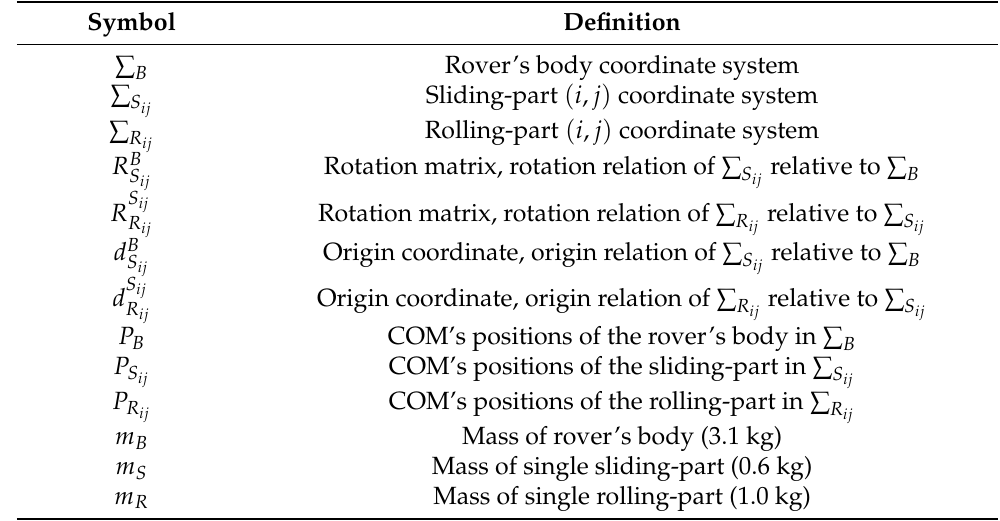
Figure 3. Geometrical parameter definitions for slope traversing. Some important distance notices are marked in the simplified rover figure. The COM’s position and wheel load can be calculated by these notices. Table 1. Symbols used in the rover